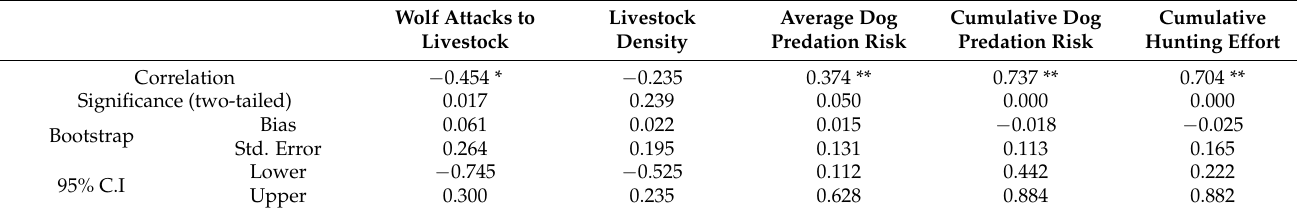
Table 4. Partial correlations ( n = 28), controlled for local village area size for “verified-probable” interactions with hunting dogs. Correlations significant only at Spearman r are denoted with “*” and those also significant after bootstrapping are denoted with “**”.